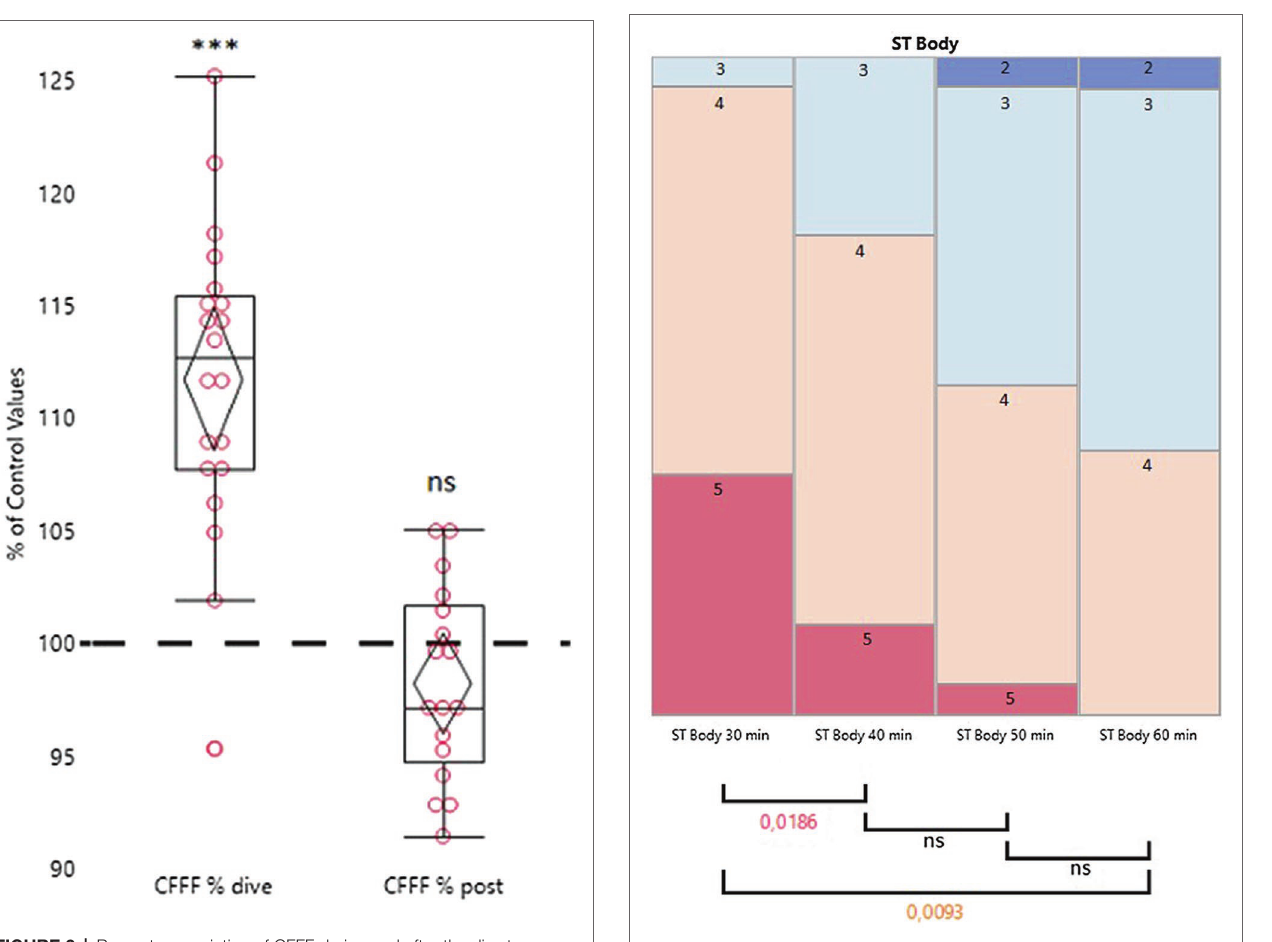
FIGURE 3 | The subjective warmth assessment for four time points at 30, 40, 50, and 60 min after the beginning of the dive. The scale is from 5 to 1, where 5 stands for neutral warmth and 1 for freezing cold. The boxes represent the percentage of answers in each category. There is a statistically significant drop in the “5” category and a statistically significant increase in the “3” category. The sample size is 22 in the ST body 30 min, ST body 40 min and ST body 50 min categories, and 20 in the ST body 60 min